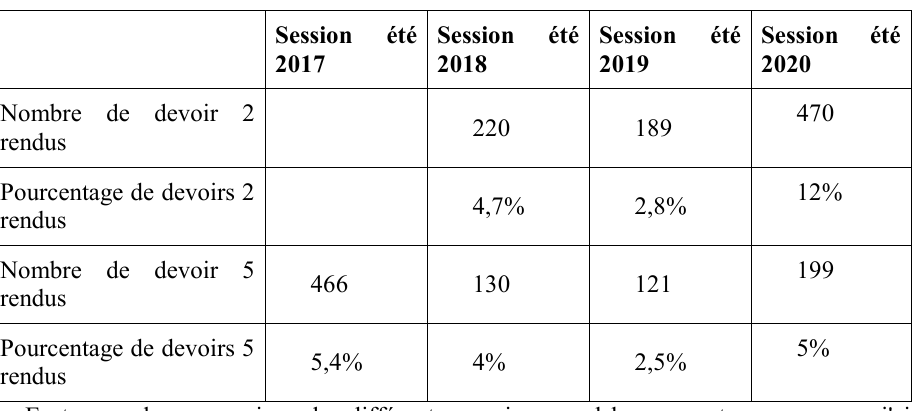
Tableau 8. Nombres d’inscrits pour les session